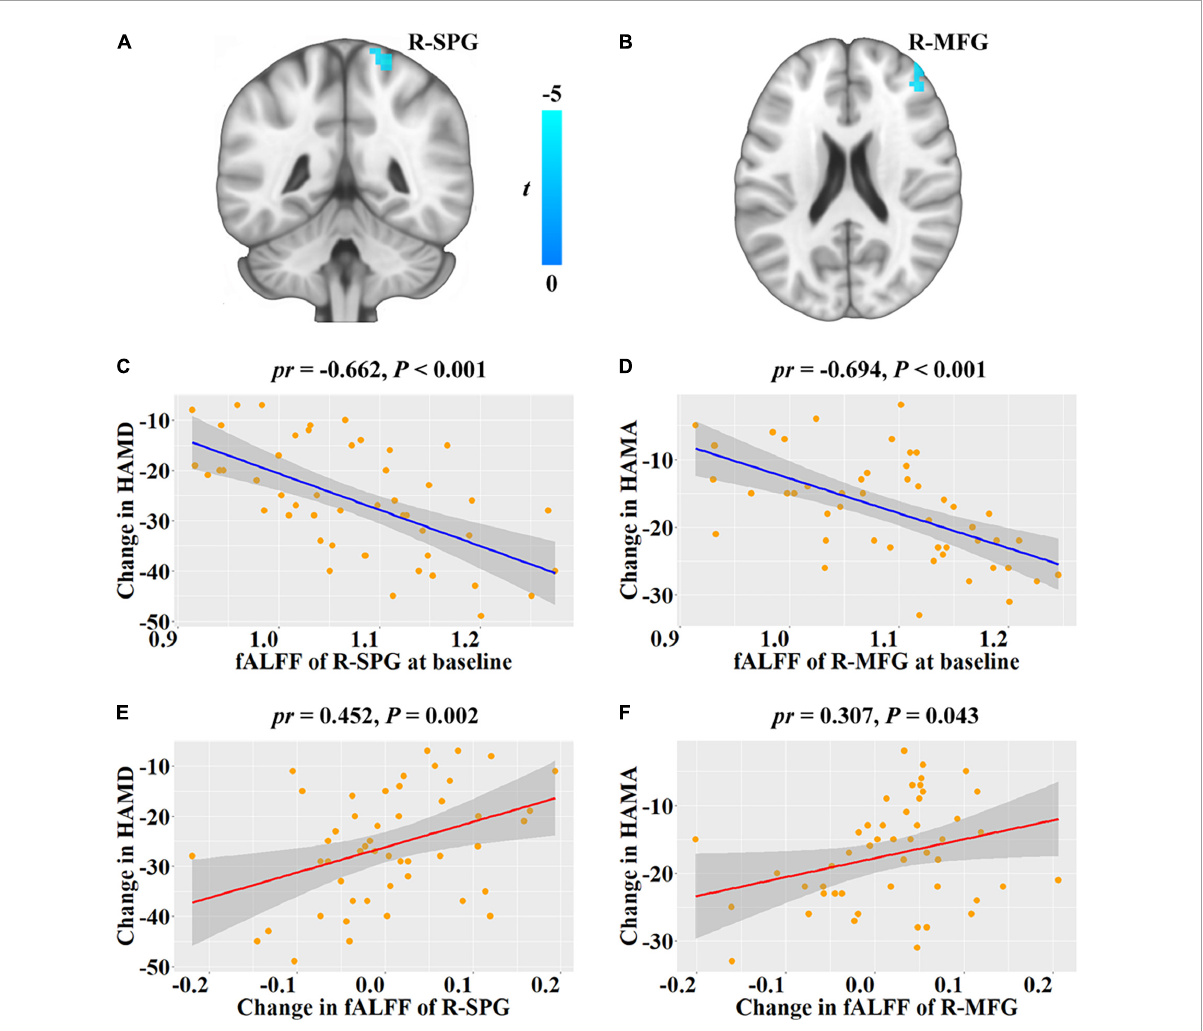
FIGURE1 Correlations between fALFF and depressive and anxiety symptoms changes from baseline to follow-up in patients with major depressive disorder. (A,B) Brain regions show significant correlations between baseline fALFF and HAMD and HAMA changes, respectively. The cold color denotes the negative correlations. (C,D) Scatter plots of the correlations between baseline fALFF of the significant clusters and HAMD and HAMA changes, respectively. (E,F) Scatter plots of the correlations between fALFF change of the significant clusters and HAMD and HAMA changes, respectively. Change = follow-up—baseline. fALFF, fractional low frequency amplitude; HAMD, Hamilton Rating Scale for Depression; HAMA, Hamilton Rating Scale for Anxiety; R, right; SPG, superior parietal gyrus; MFG, middle frontal gyrus; pr , partial correlation